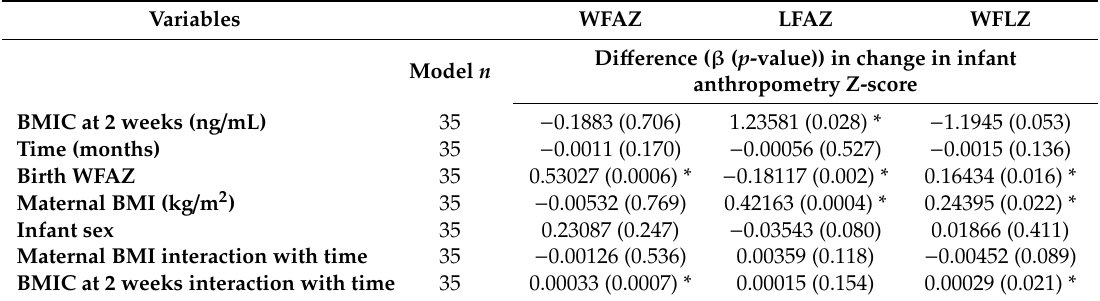
Table 3. Association of maternal weight status and 2 week breast milk iodine concentration with change in weight-for-age, length-for-age, and weight-for-length Z-score across the first year of life. Variables WFAZ